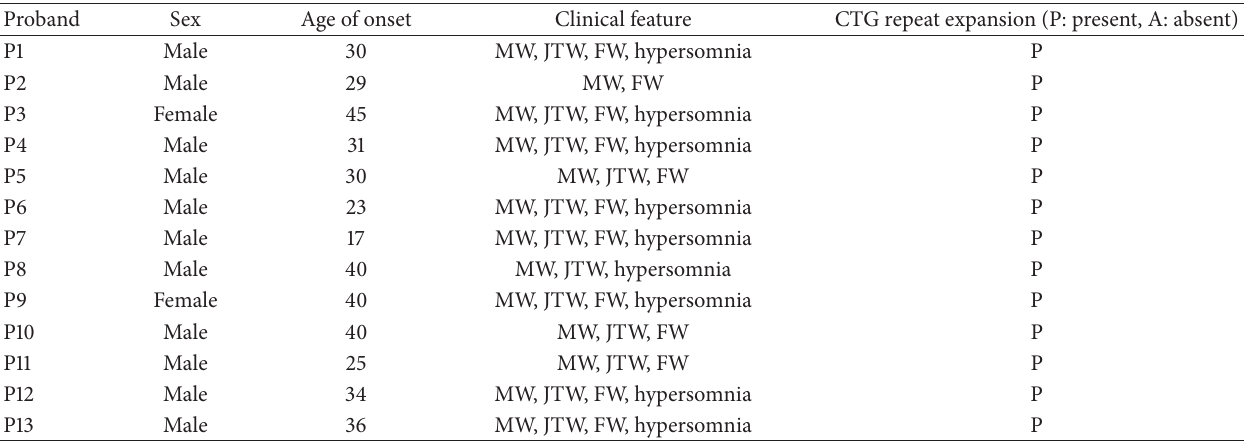
Table 2: Clinical and molecular profiles of